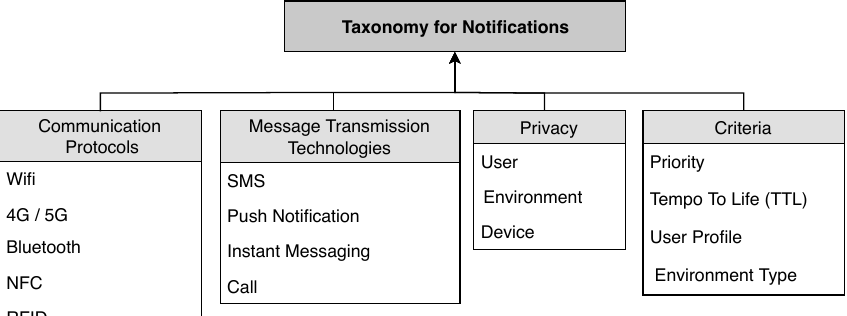
Figure 1. Taxonomy for Notifications Management